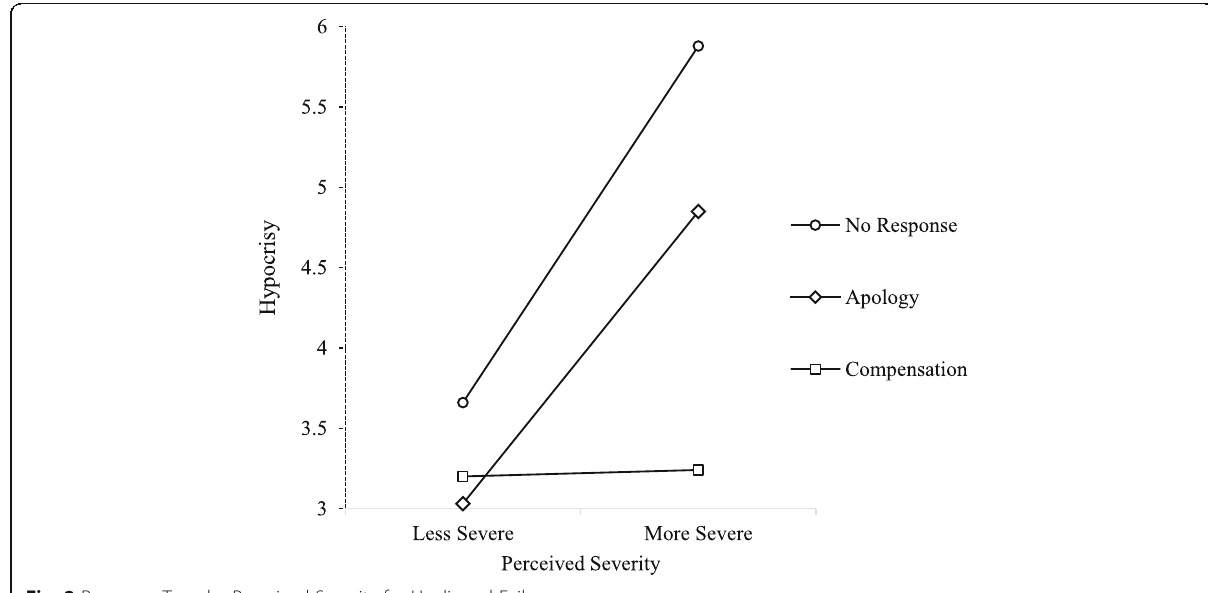
Fig. 2 Response Type by Perceived Severity for Unaligned